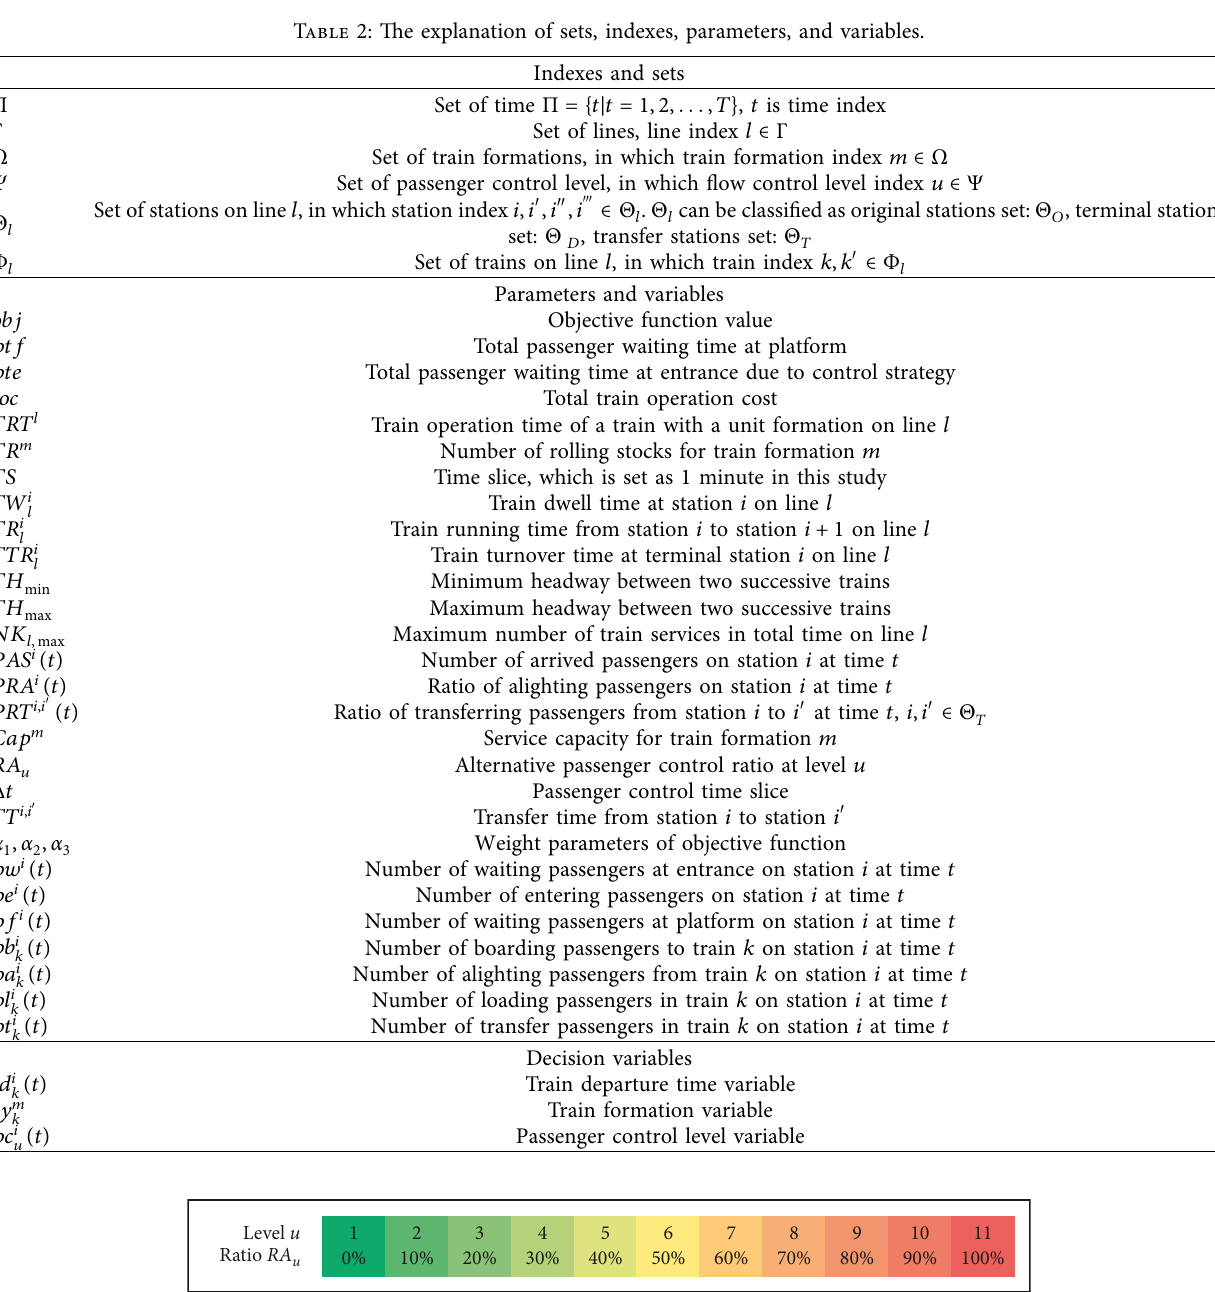
Figure 2: The diagram of passenger control level.